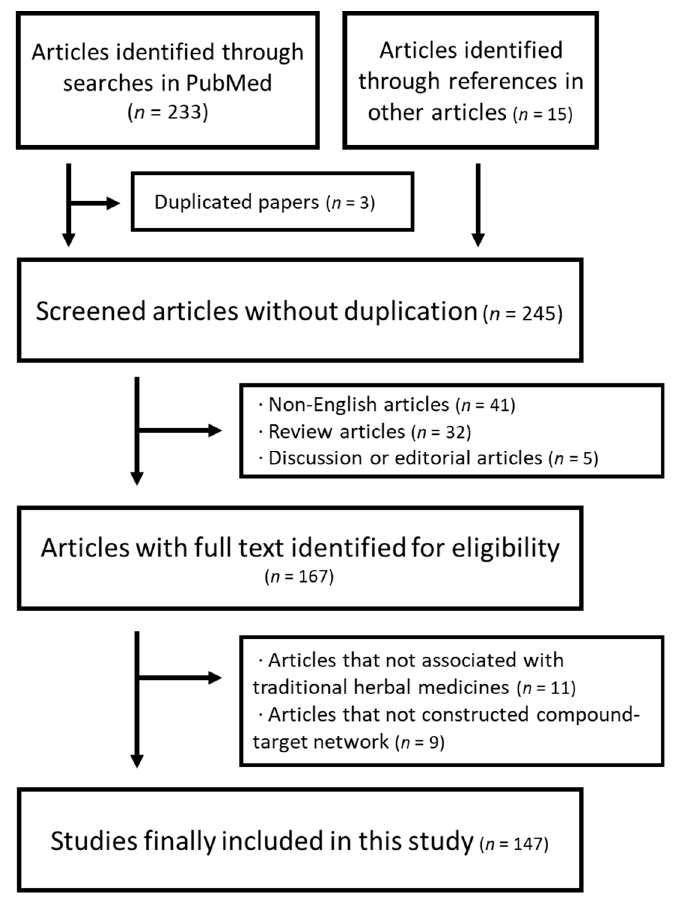
Figure 2. The flowchart of the study selection process.